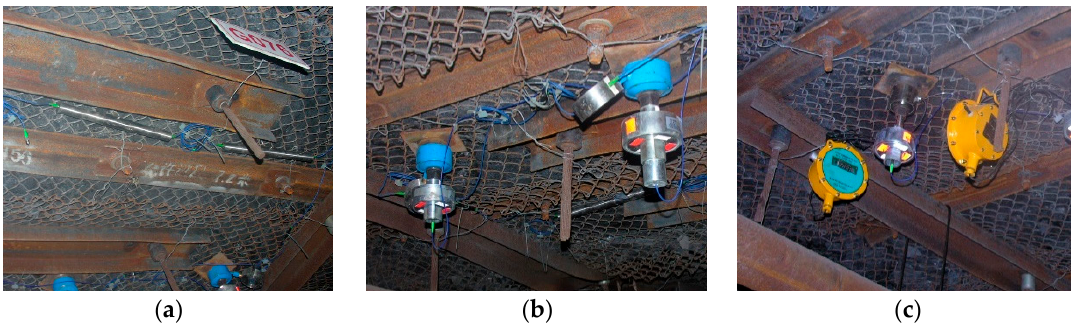
Figure 15. Field implementation of all measurement equipment: ( a ) FBG roof separation sensors; ( b ) FBG stress sensors; ( c ) Electric pressure gauges.